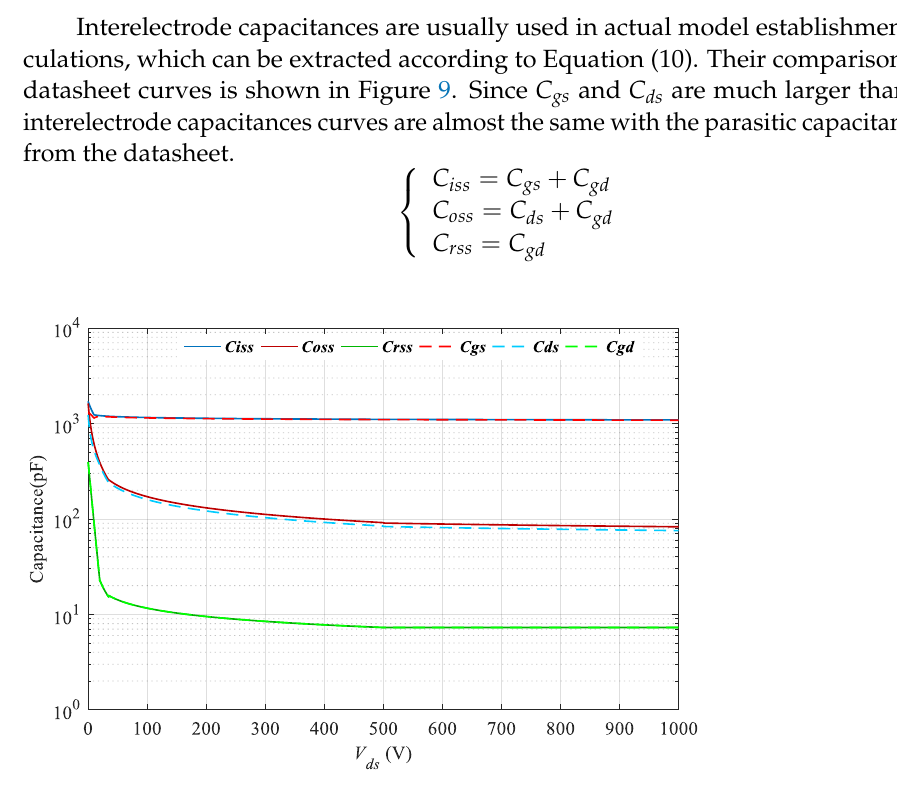
Figure 9. Comparison between the capacitances from datasheet and the interelectrode capaci- tances.